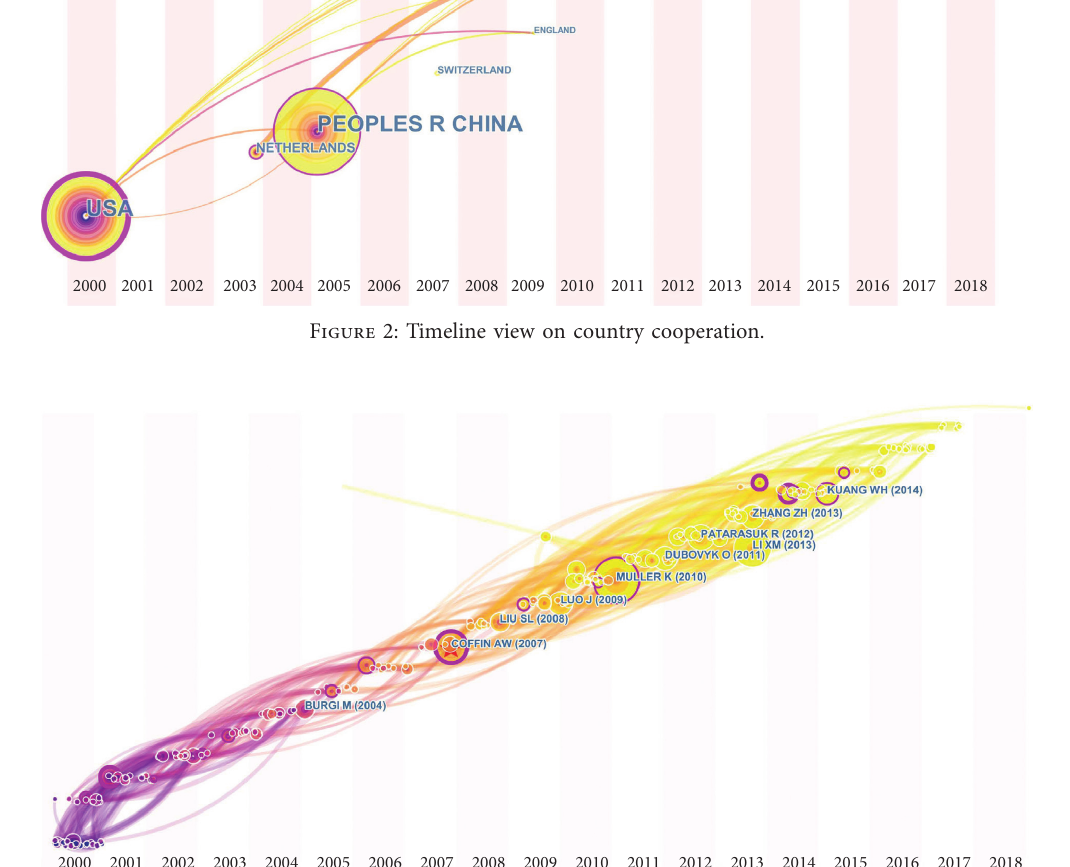
Figure 3: Timeline view on literature